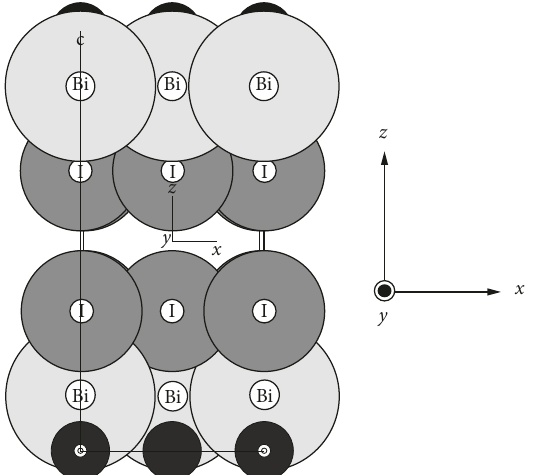
Figure 1: Schematic representation of the Bravais cell for